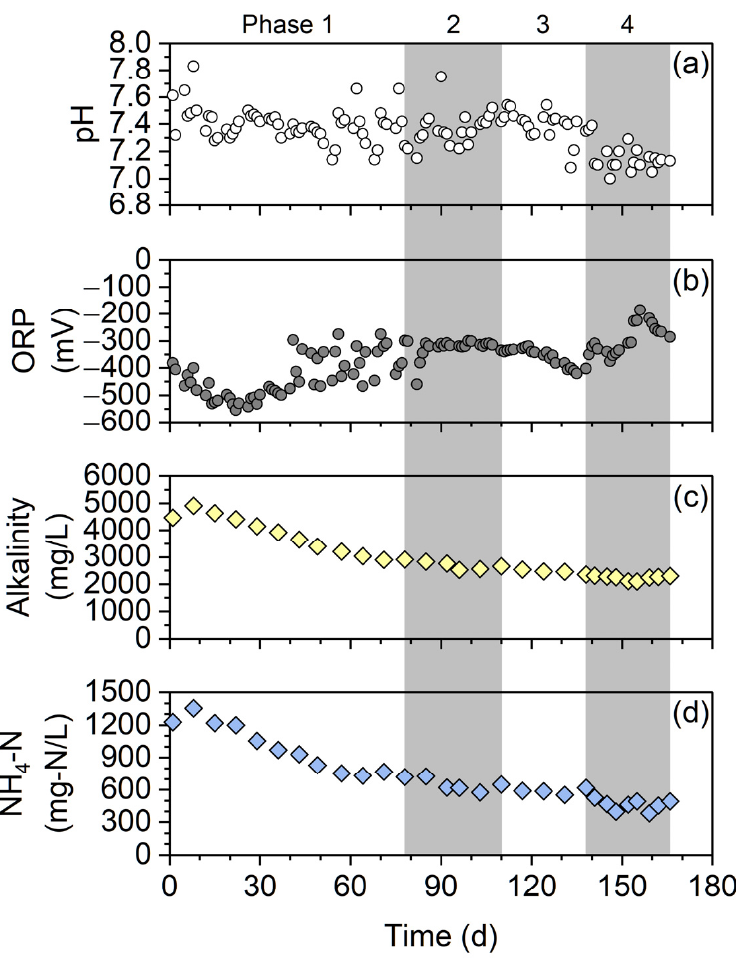
Figure 4. ( a ) pH, ( b ) ORP, ( c ) alkalinity, and ( d ) NH 4 -N concentration in the digestor. The COD concentration in the digested sludge (i.e., T-COD) was in the range 8200–21,400 mg/L, and it gradually increased from 9600 to 16,700 mg/L during phases 2–4, while membrane filtration continued (Figure 5a). During phases 2–4, the COD concentra- tion in the membrane permeate (i.e., the soluble COD) stabilized at 190 mg/L (Figure 5a). Overall, the efficiency of COD rejection by the membrane was greater than 96%. This is attributed to the membrane’s highly efficient rejection of suspended COD. The same trend was observed for the TS and VS concentrations (Figure 5b). Solid–liquid separation by the membrane increased the concentrations of T-COD, TS, and VS during phases 2–4. The membrane thickened the digested sludge and helped retain it inside the digester, which led to a higher content of microbial biomass. This originated from a distinctive feature of AnMBRs, that is, the decoupling of the HRT and SRT. AnMBRs can prolong the SRT without simultaneously extending the